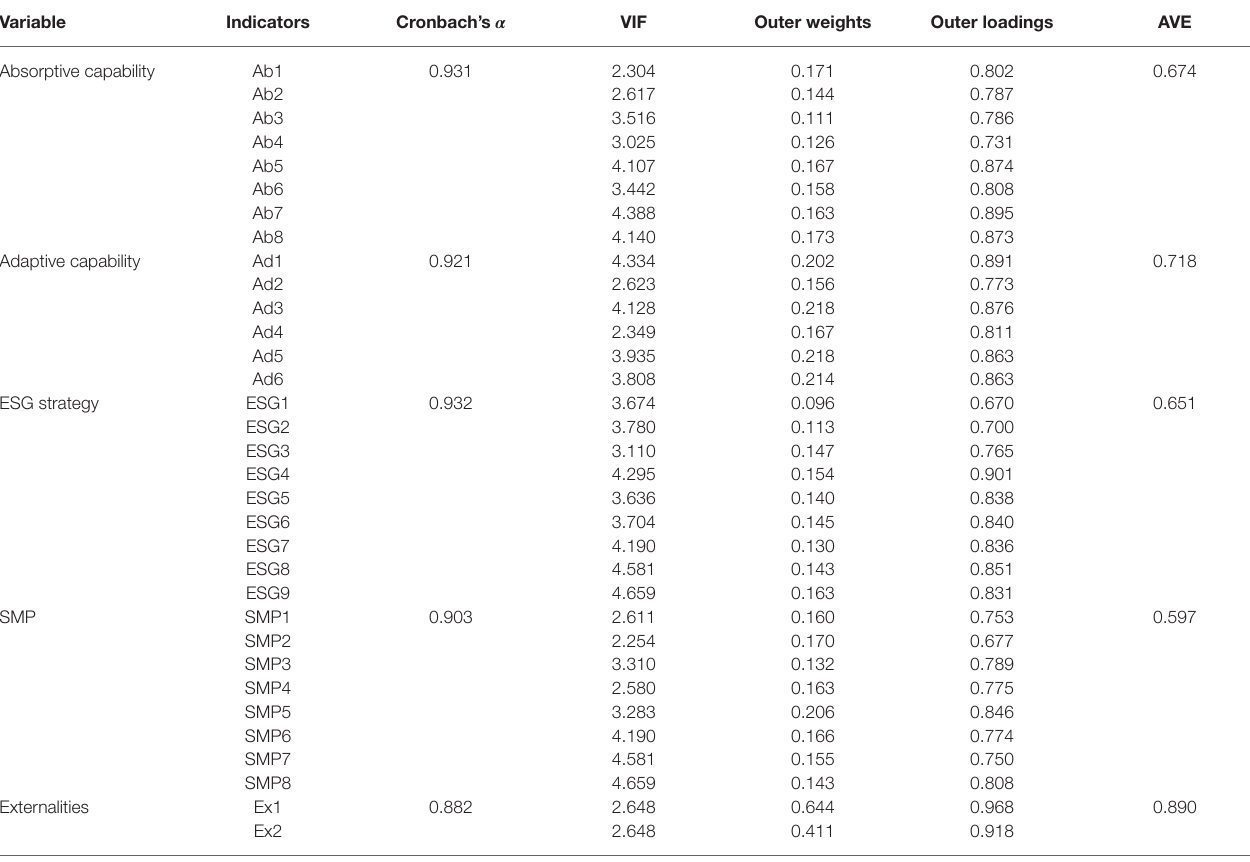
TABLE 2 | Analysis results from measurement model.